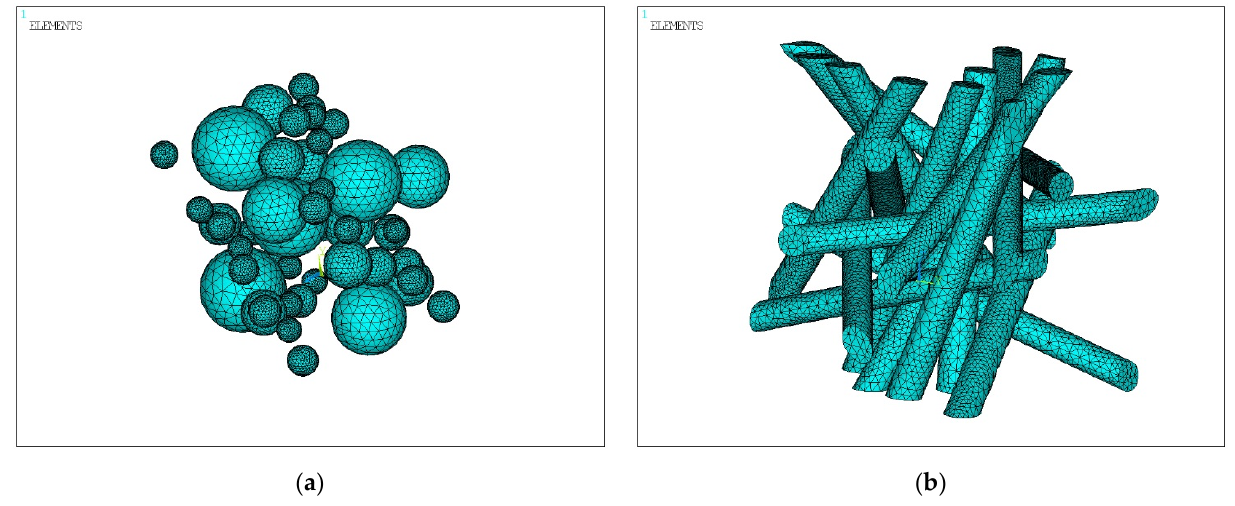
Figure 4. Finite element models of fillers with spherical ( a ) and cylindrical ( b ) inclusions. Additionally, one of the lower vertices (lower) of the cube was fixed from linear dis- placements (spherical hinge) to ensure the kinematic immutability of the model. The load- ing was applied by negative pressure on the upper face (upper) of the cube, which was equal to the tensile strength of the corresponding composite material. The tensile process of the sample with normal stress corresponding to the experimental material strength limit was modeled: 18.6 MPa for spherical filler and 19.1 MPa for cylindrical filler.